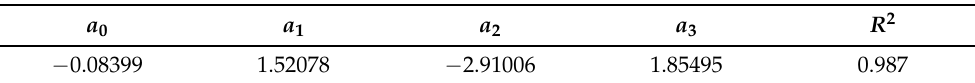
Table 1. Fit parameters for the E b / ( Mc 2 ) – Λ relation of Equation (31). The R 2 index is also included for completeness.